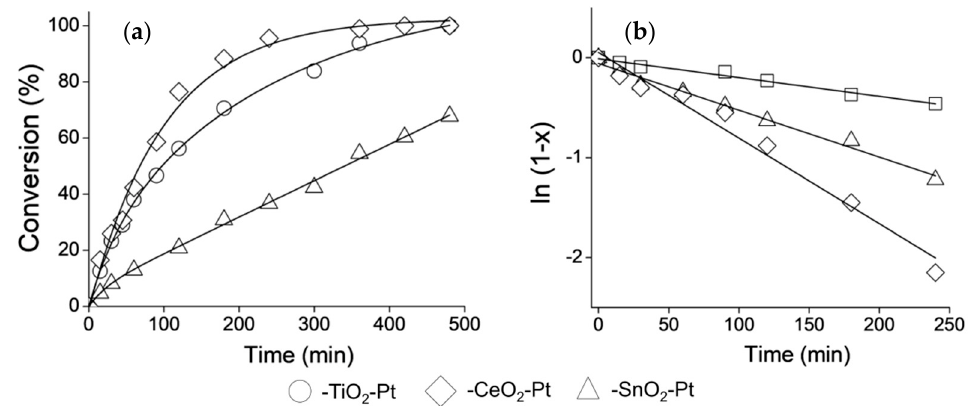
Figure 6. Catalytic evaluation of Fe 2 O 3 –SiO 2 –MeO 2 –Pt (Me = Ti, Sn, Ce) in CAL Hydrogenation. ( a ) Conversion curves and ( b ) Pseudo-first order kinetic model adjustment.